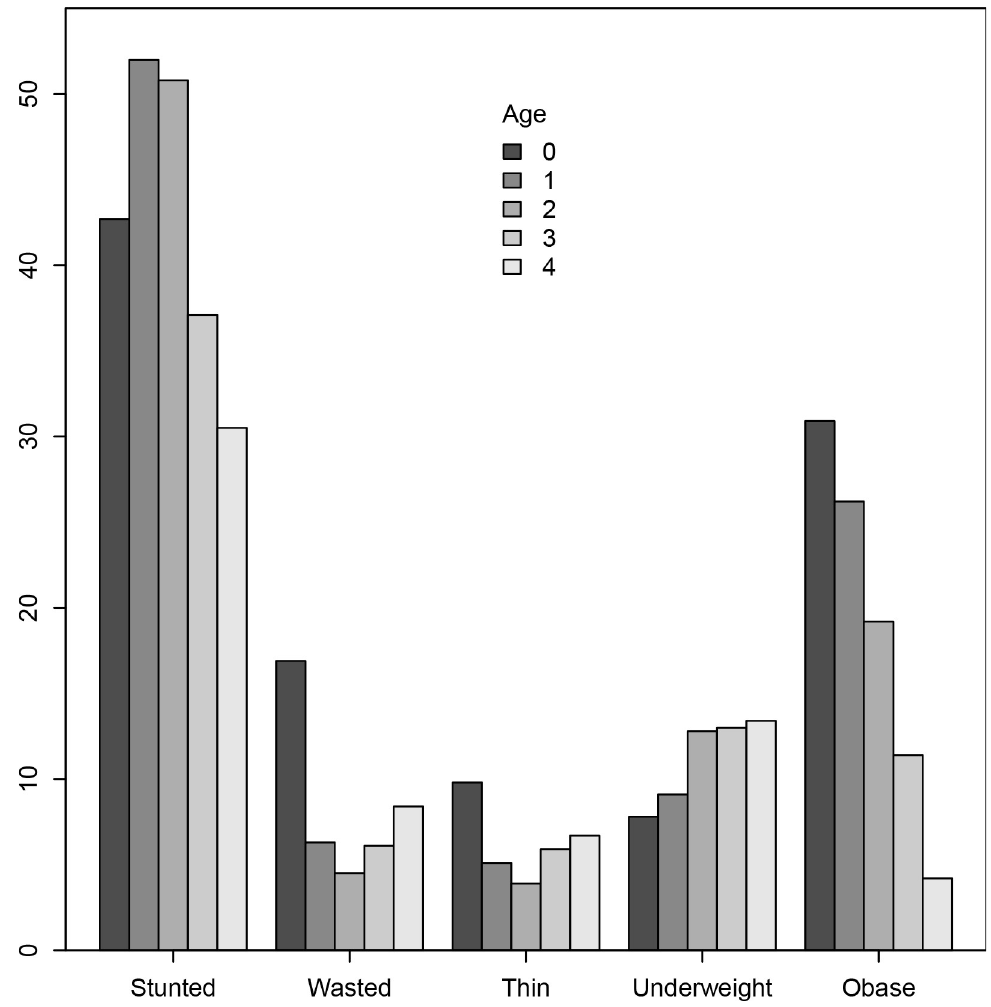
Fig 1. Nutritional characteristics of the study population in relation to age